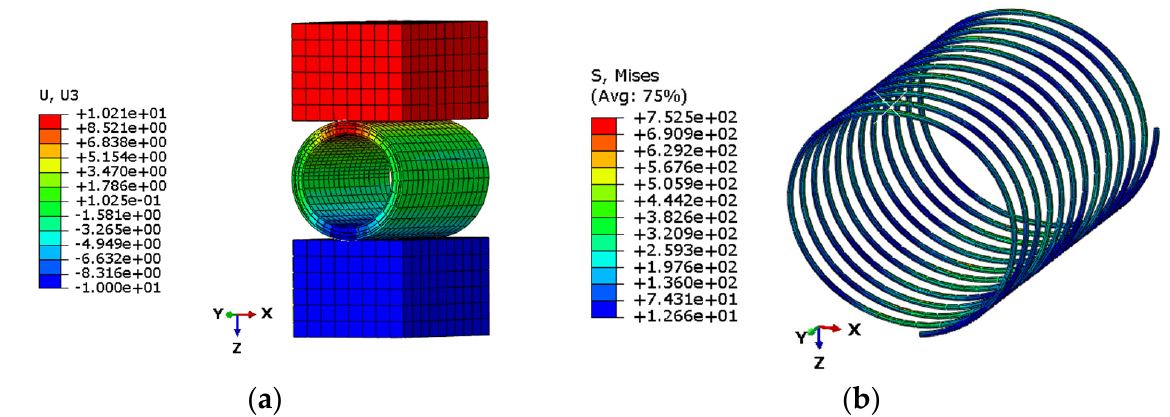
( b ) Figure 9. FE model for the crush simulation: ( a ) general configuration; ( b ) boundary condition. A displacement of 10 mm is loaded to the hose, under which the displacement of the hose and the stress distribution on the steel wire are plotted in Figure 10. It shows the maximum stress of the wire is 752.5 MPa, which is lower than its yield stress, which im ‐ plies the deformation is in the elastic range. This is also demonstrated by the linear load ‐